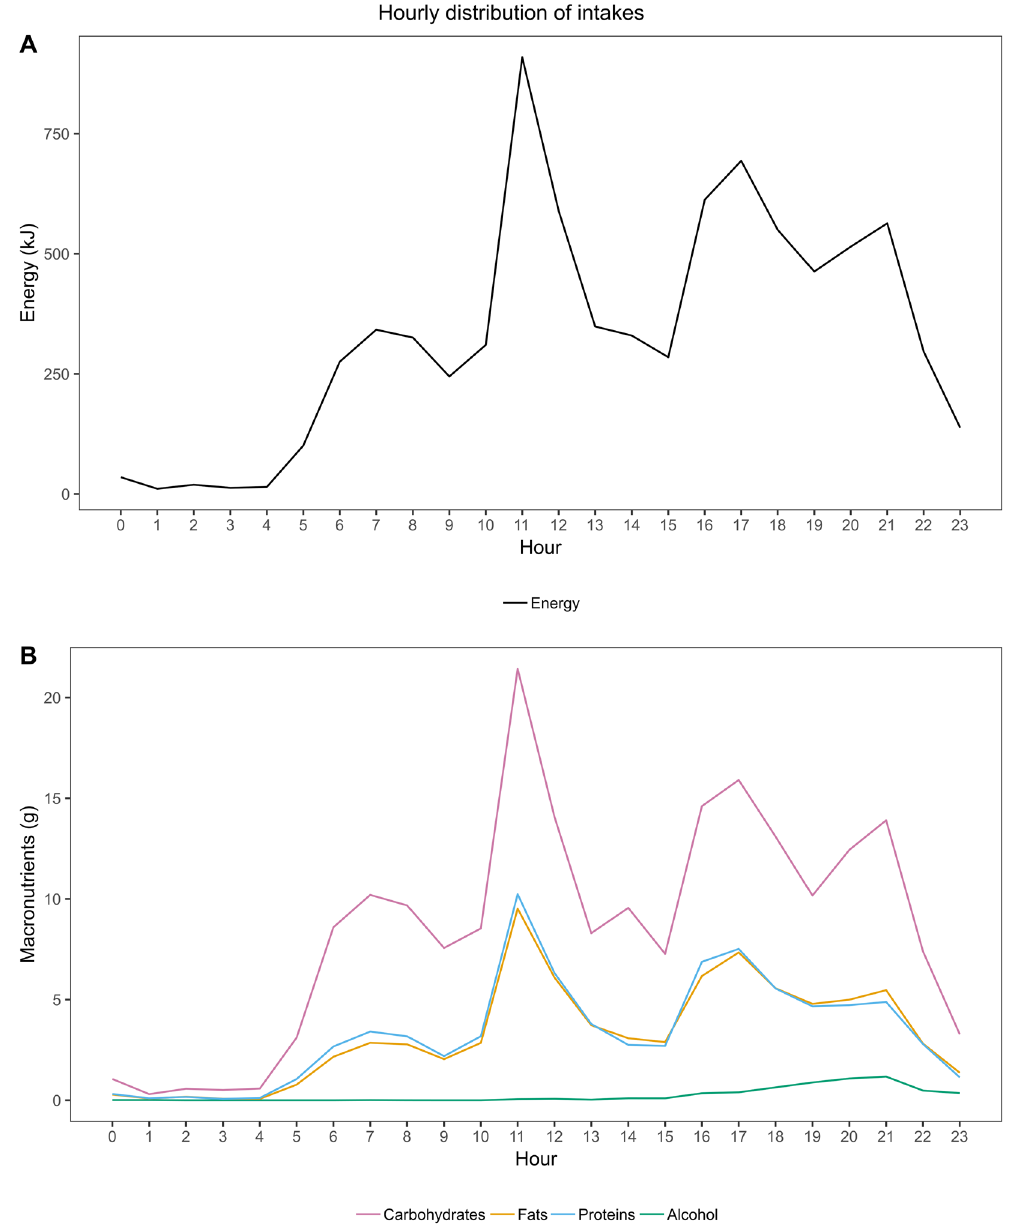
Figure 1. Hourly distributions of energy and macronutrient intakes of the whole sample. ( A ) Energy intake in the whole sample. ( B ) Macronutrient intakes in the whole